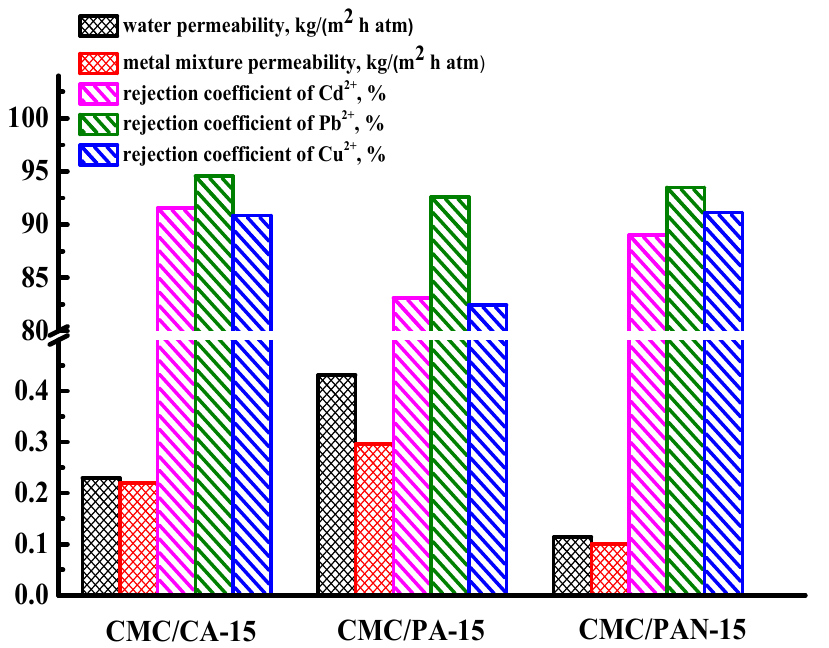
Figure 8. Transport properties of the supported CMC-based membranes in nanofiltration of water and a model solution of heavy metal ions (Cd 2+ , Pb 2+ , Cu 2+ ).